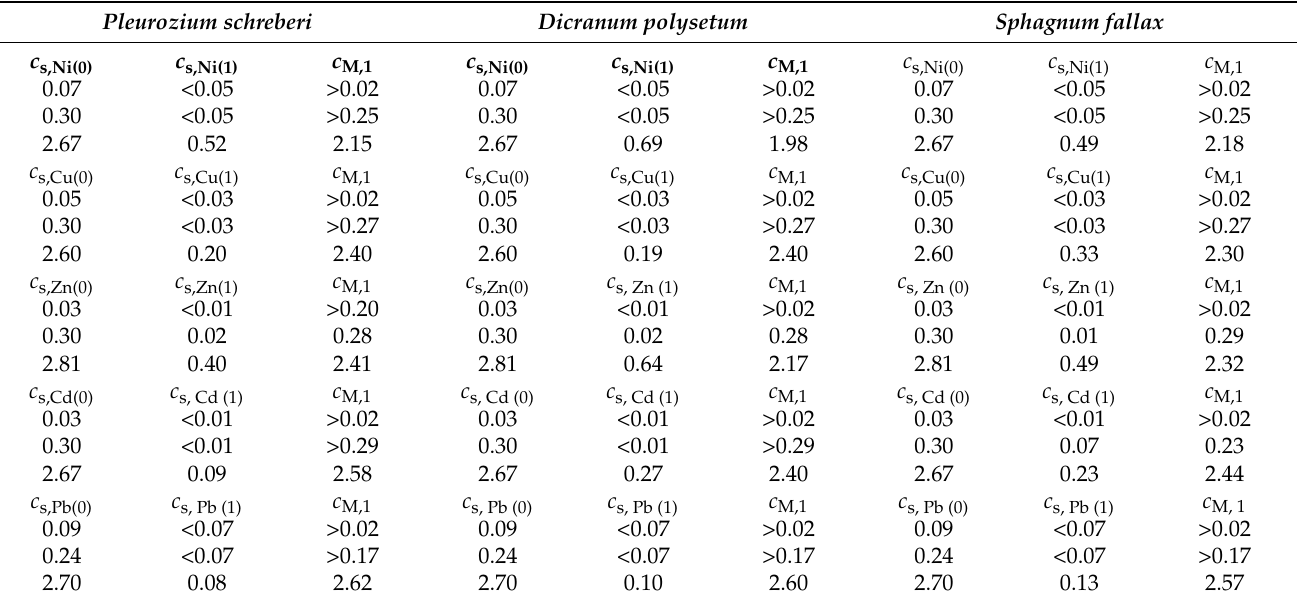
Table 3. Changes in elemental concentrations in solutions [mg/L] and in mosses [mg/g d.w.] during the sorption process ( n =